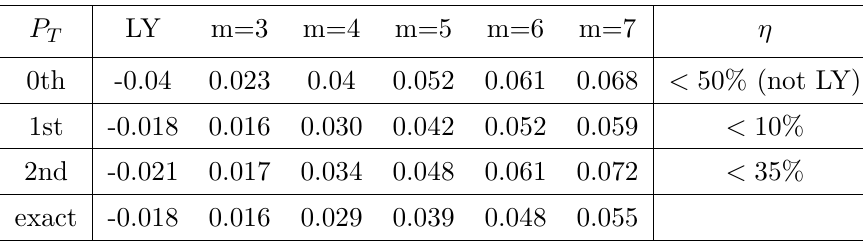
Table 4 . The estimates of the OPE coe(cid:14)cient P T at di(cid:11)erent approximation orders and their exact values. LY stands for the 2d Lee-Yang CFT. 2d unitary minimal models M ( m + 1 ; m ) are denoted by m . We only show two signi(cid:12)cant (cid:12)gures. The optimal estimates are from the (cid:12)rst order approximations. Surprisingly, the approximate equation P (1) in (3.28) generates the exact T